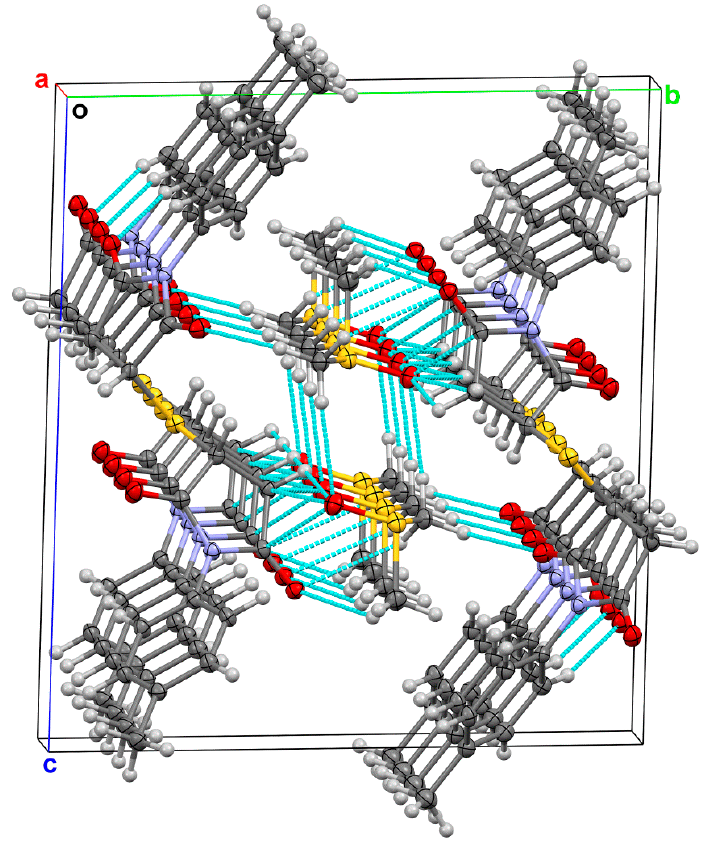
Figure 2. Packing plot of 3b •DMSO along the a axis ( p = 50%). Non-covalent short contacts are shown with blue dashed lines.